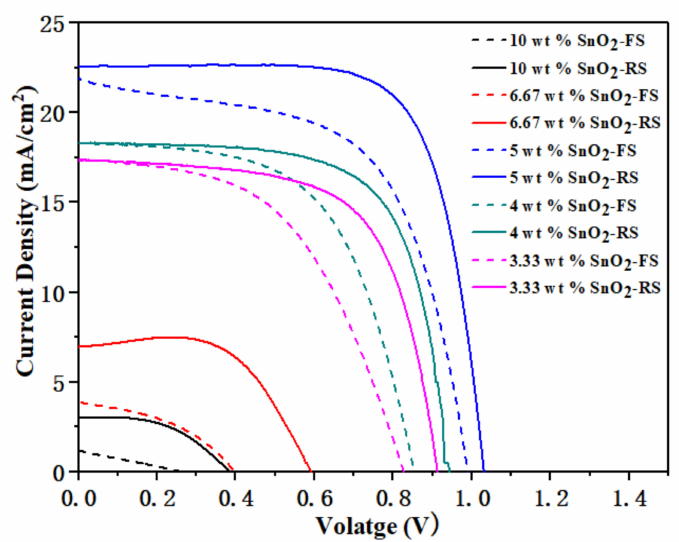
Figure 3. The current density–voltage (J–V) curves for perovskite solar cells made with SnO 2 colloid solution with different